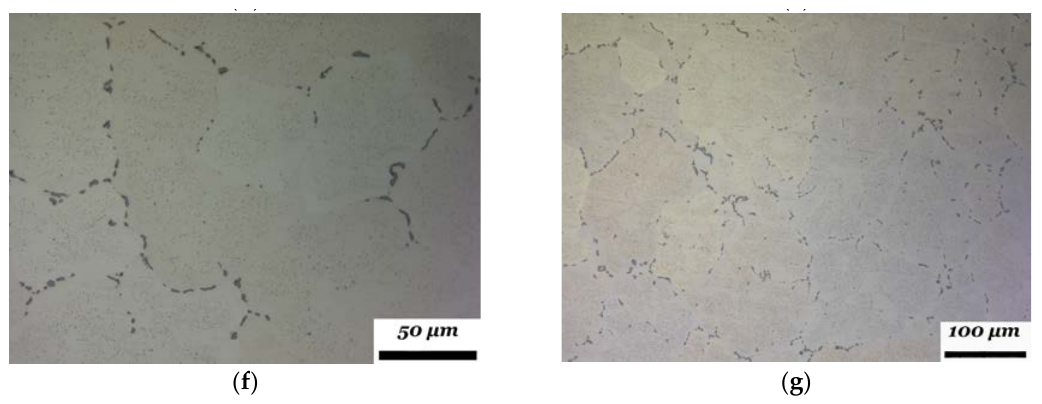
Figure 2. Metallographic images: as-cast ( a ); homogenized at 560 °C ( b ) and ( c ) for 2 h; ( d ) and ( e ) for 4 h; ( f ) and ( g ) for 6 h.